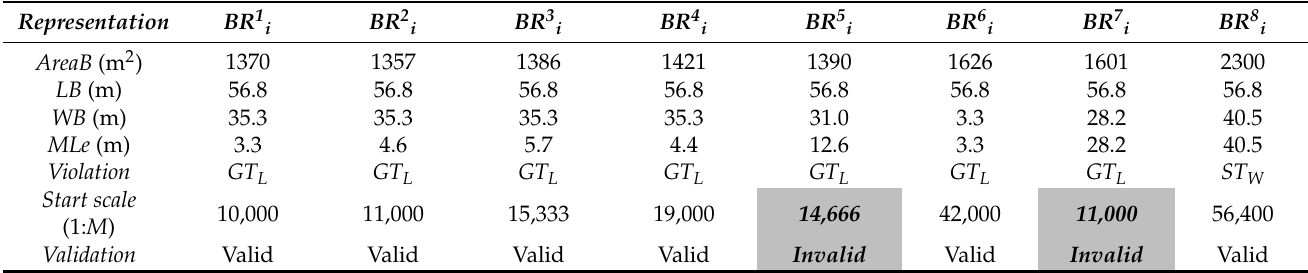
Figure 11. Construction of data structure: two matched rows recording representation of B i and its corresponding scales: (cid:110) (cid:110) (cid:111) (cid:111) BR = BR 1 i , BR 2 i , . . . , BR n i Scale 1 i < Scale 2 i , Scale n i and SS = . Representation of B i at target scale can be obtained by searching along with SS and BR . Table 5. Parameters describing legibility constraint for representations of B i in Figure 11, which can help obtain correspond- ing scale of each representation. Invalid scales are highlighted in the